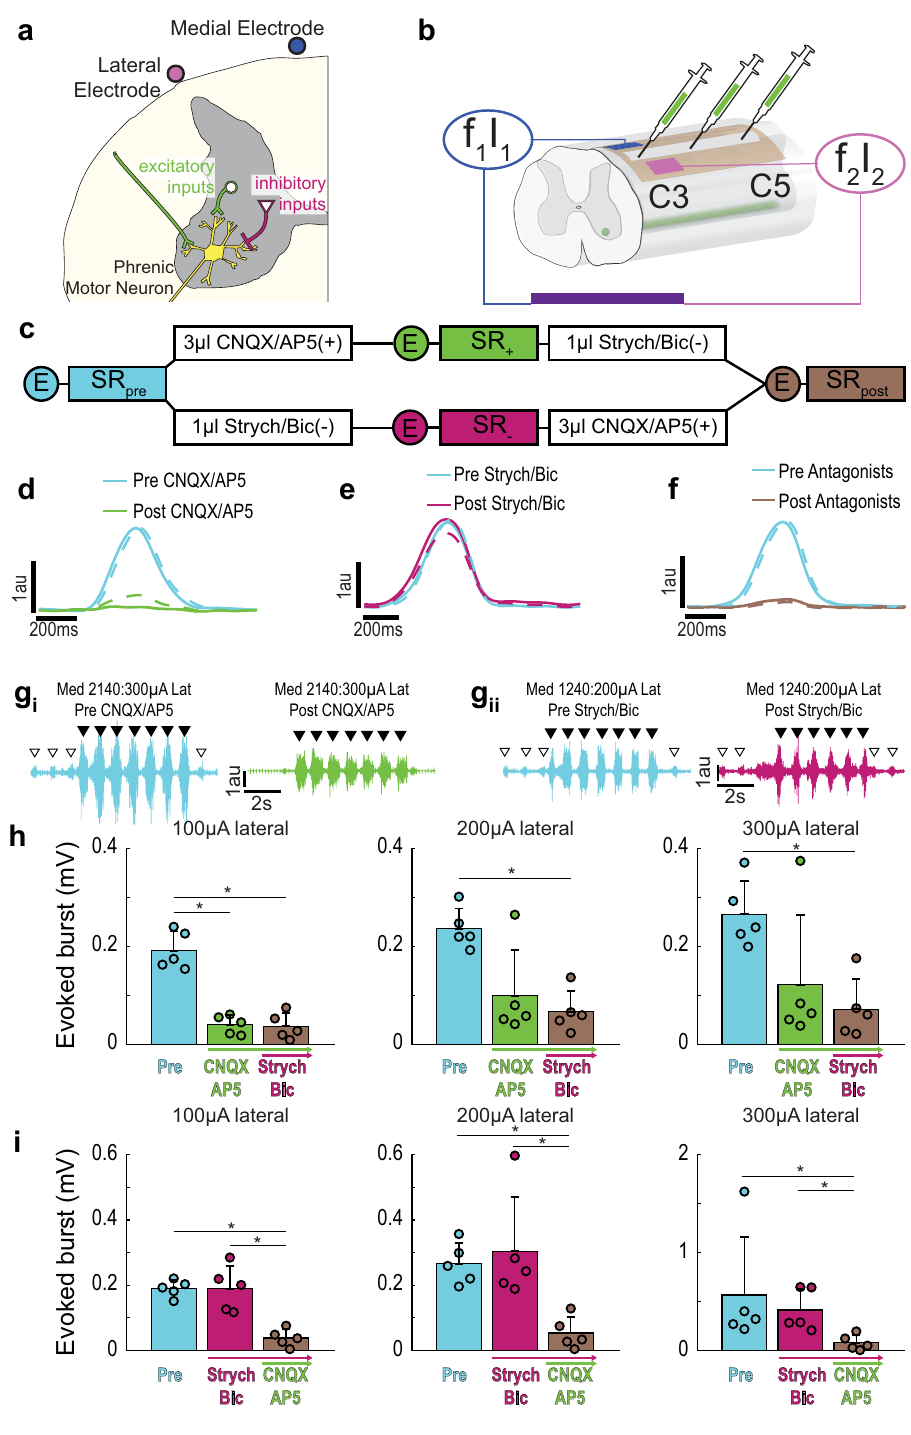
(Supplementary Fig. 5a). Square wave stimulation at 50 pulses per second (pps) was able to elicit compound muscle action potentials in the diaphragm with concurrent biceps activation. These muscle action potentials did not summate into a sus- tained diaphragm burst as occurs during inspiration (Supple- mentary Fig. 5b). Square wave stimulation at 300 pps evoked a square wave diaphragm burst (Supplementary Fig. 5c) con- current with large amplitude activation of the biceps muscle on the corresponding side. In addition, both the 50 pps and 300 pps stimulation caused widespread muscle activation throughout the